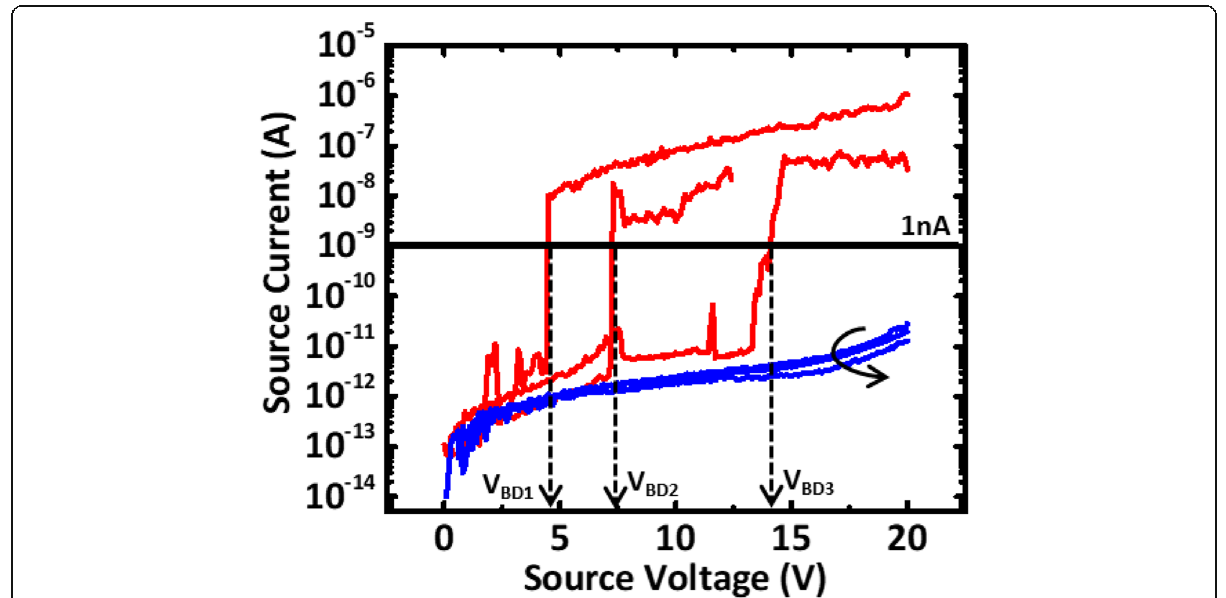
Fig. 3 Leakage current measured on devices with differential test patterns connected to metal-3 antenna of 82,000 μ m 2 . V BD is defined as the voltage as the current reaches 1 nA for a via length of 32 nm